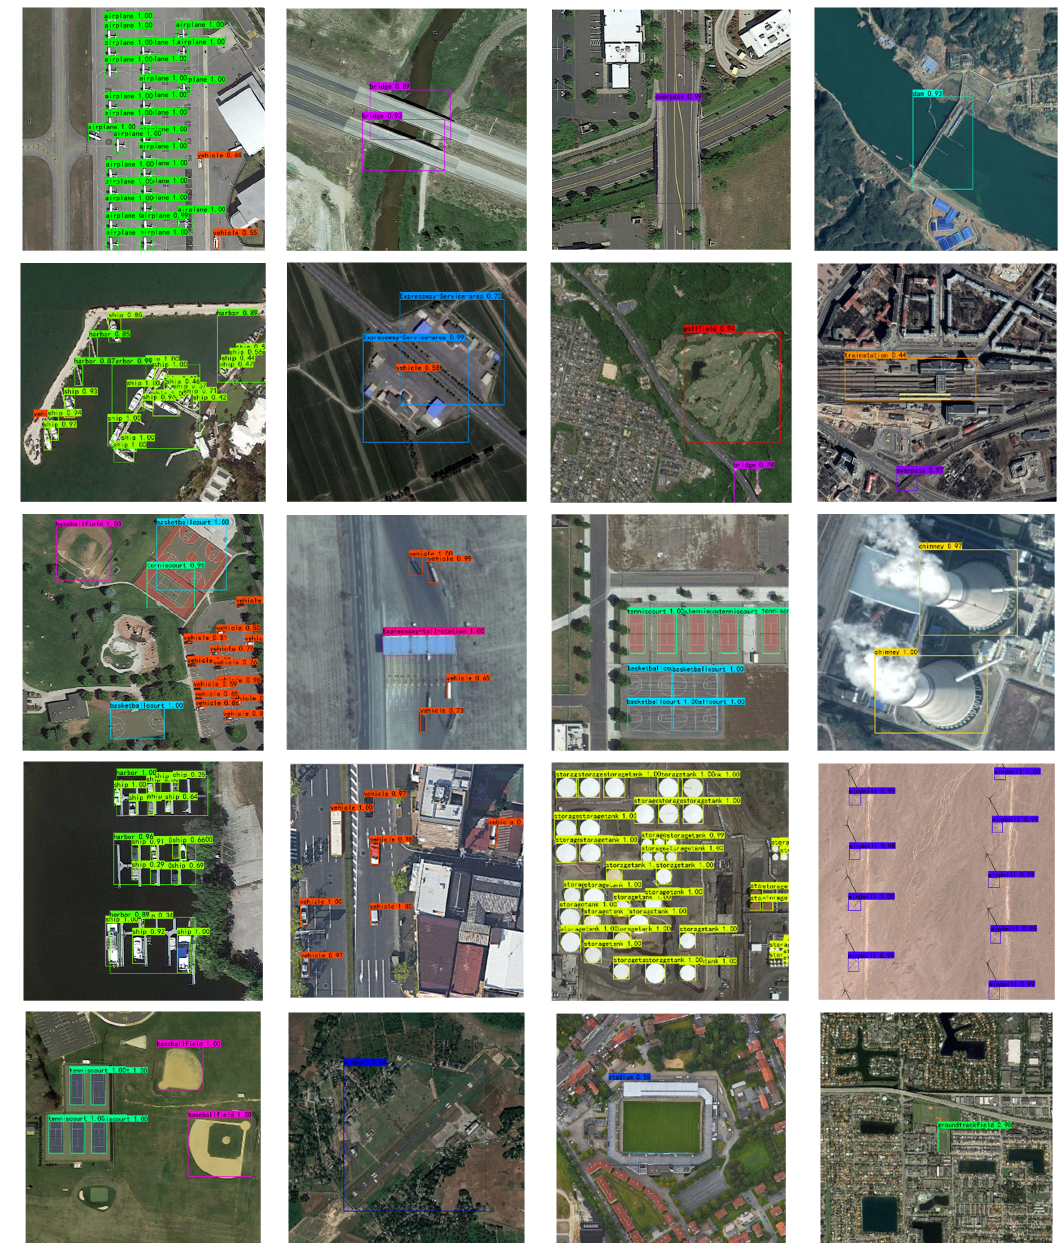
Figure 10. DIOR dataset detection results.